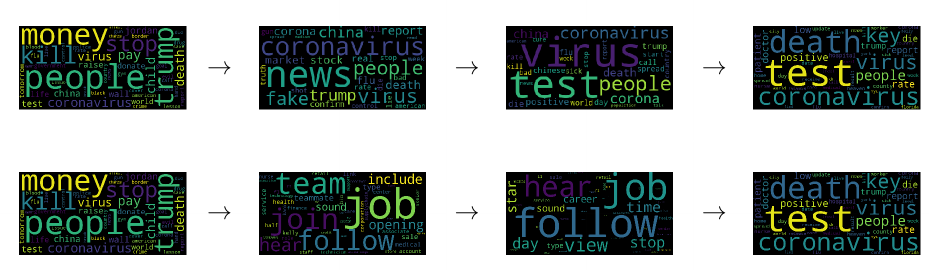
Figure 2. Evolution along the Hellinger shortest paths of a COVID-19 topic on February 15, 2020, to a COVID-19 topic on May 15, 2020 . The paths are